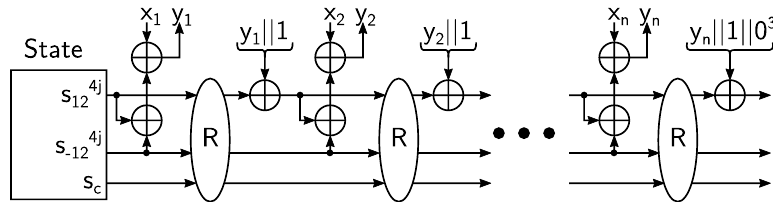
Figure 8: Subterranean absorb with operation decryption.